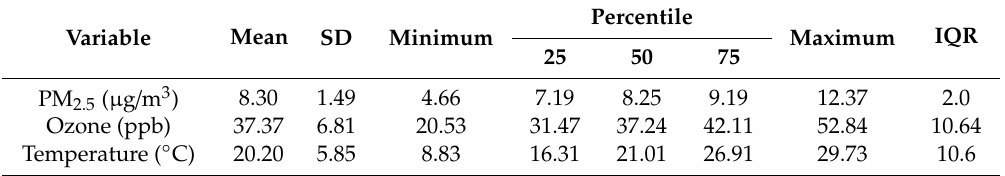
Table 2. Summary statistics of daily ambient air pollutant concentrations and daily temperature in South Texas between 2010 and 2014.